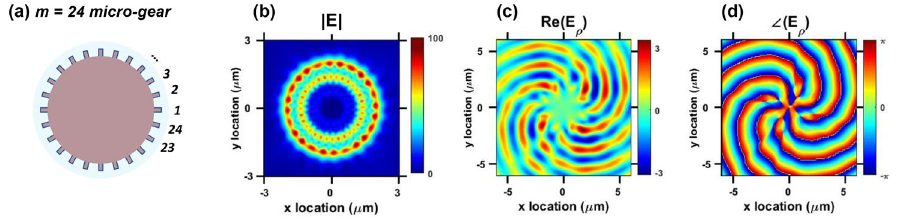
Figure 3. Higher-order whispering-gallery mode (WGM) example: ( a ) sketch of m = 24 micro-gear cavity. ( b ) Magnitude of the electric field components of TE 16,2 (at 1675 nm) captured at the top surface of the micro-gear. ( c ) Real value of E θ captured at 0.5 µ m above the micro-gear. ( d ) The corresponding phase plot indicates an OAM order of